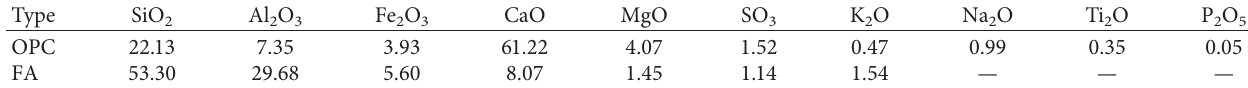
Table 1: Chemical composition of ordinary Portland cement and fly ash (%).